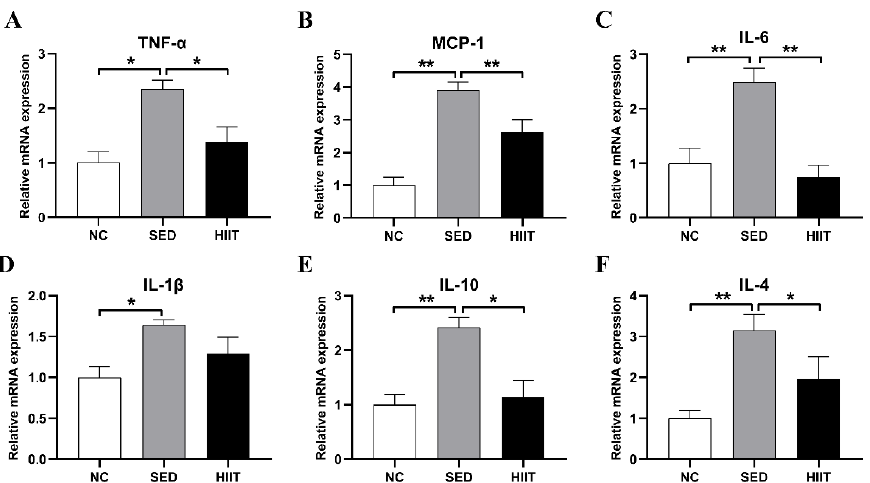
Figure 4. HIIT reduces liver inflammation in T2DM mice. ( A – F ) The mRNA expression levels of TNF- α, MCP -1, IL-6, IL- 1β, IL -10, and IL-4. Values are mean ± SEM (n = 8 per group). * p < 0.05, ** p TNF- α , MCP-1, IL-6, IL-1 β , IL-10, and IL-4. Values are mean ± SEM (n = 8 per group). * p < 0.05, < 0.01. ** p <